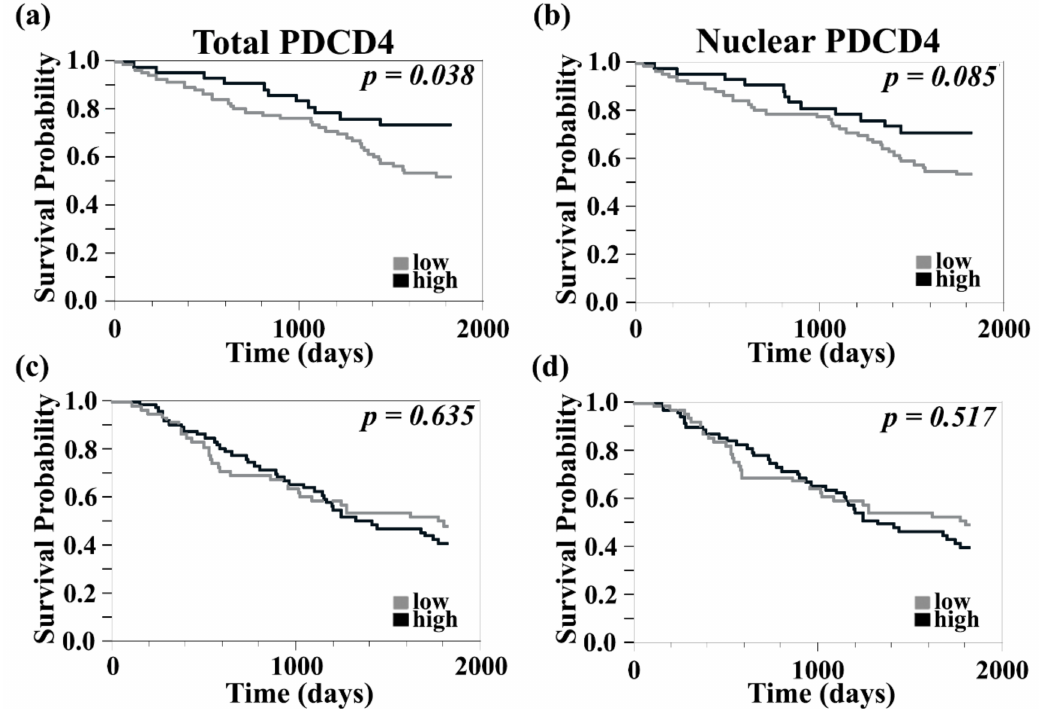
Figure 2. Improved 5-year survival in primary but not metastatic melanomas with high PDCD4 expression. ( a ) The 5-year survival in primary melanomas was improved with high total PDCD4 expression but ( b ) only associated with a trend towards improved survival with high nuclear PDCD4 expression. High PDCD4 expression was not associated with improvements in 5-year survival in metastatic melanoma regardless of whether expression was analyzed within the total tumor ( c ) or the nuclear compartment ( d